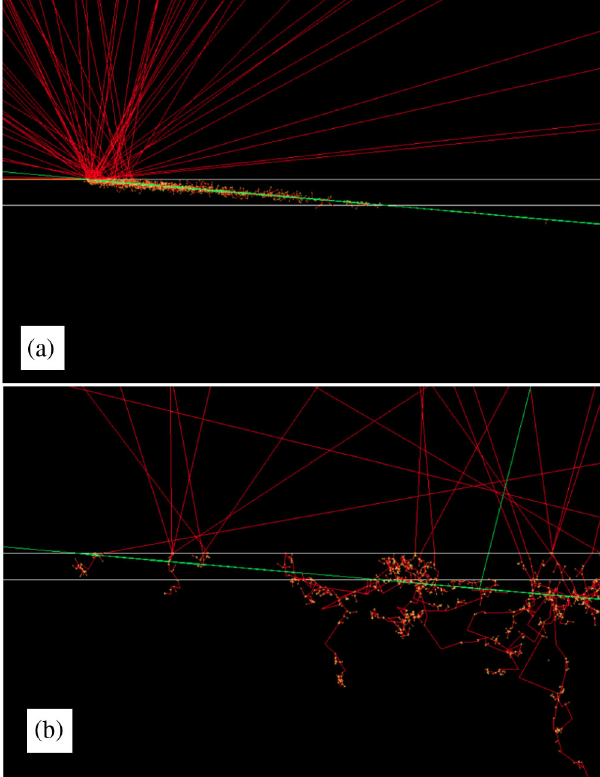
FIG. 15. Tracks from incident photons (green), initially trav- eling left to right, and subsequently generated electrons (red) in the G EANT 4 simulation for photon energies of (a) 30 eV and (b) 2 keV. Low-energy photons interact primarily with the 5-nm CO layer, while the higher energy photons interact in the aluminum. Electrons produced by photoeffect reach the interior of the vacuum chamber via rescattering, while those produced radially symmetrically by atomic deexcitation processes can exit the wall more